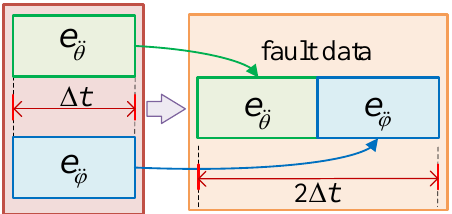
Figure 4. Actuator fault data feature fusion process. ∆ t is the sampling length. The pitch angular acceleration residuals e ¨ and roll angular acceleration residuals e ¨ ϕ of the corresponding time are θ spliced, that is, the fault data containing unknown fault information is finally